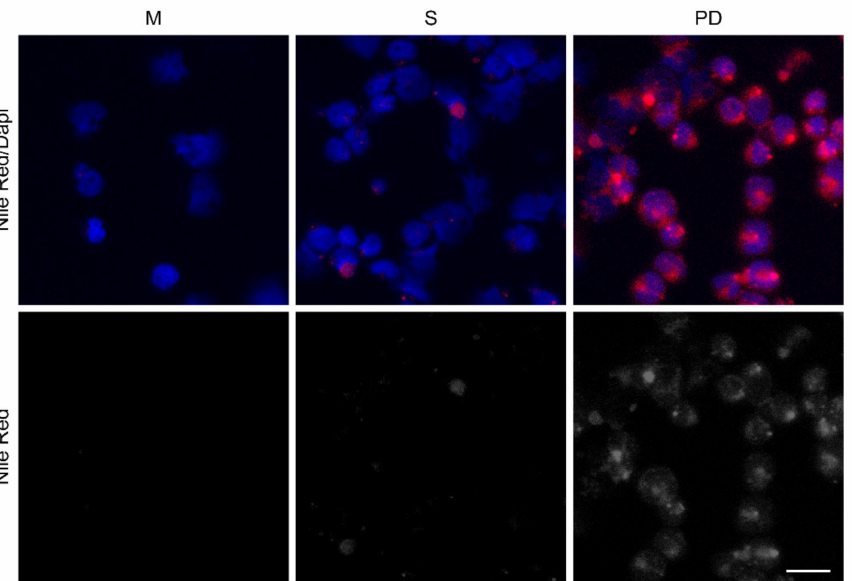
Figure 3. Drug-resistant phase dim (PD) cells have increased lipid content. REH cells were co- cultured with (HOB), and the cells in suspension (S) and the phase dim (PD) cells were isolated and compared to REH cells grown in media alone (M). Nile Red staining was completed to visualize lipid content. Scale bar = 20 µ m. Red (Nile Red); Blue (DAPI nuclear